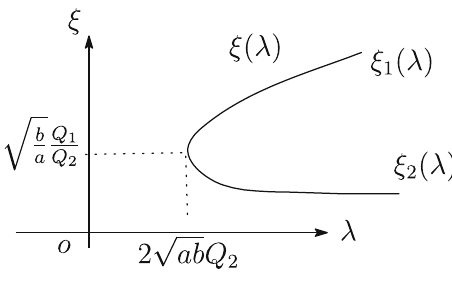
Figure 3: The graph of ξ λ ( ) for p 2 =